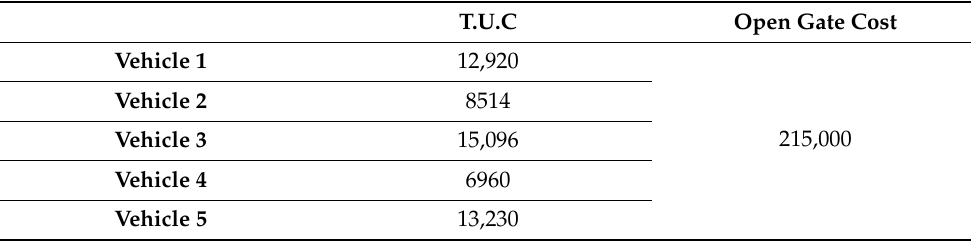
Table 9. T.U.Cs of the vehicles and the open gates cost in solution